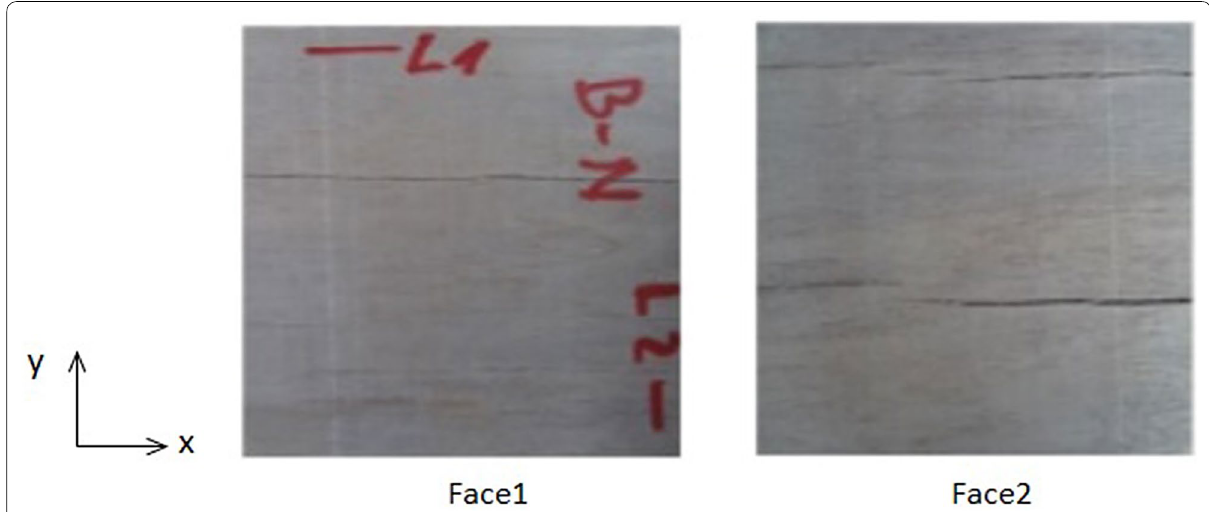
Fig. 14 Experimental results of the faces of plywood